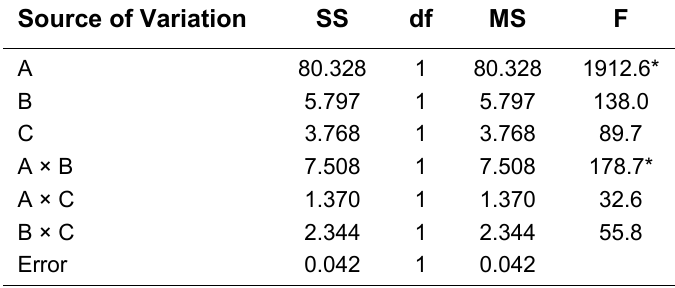
Variance Analysis of Experimental